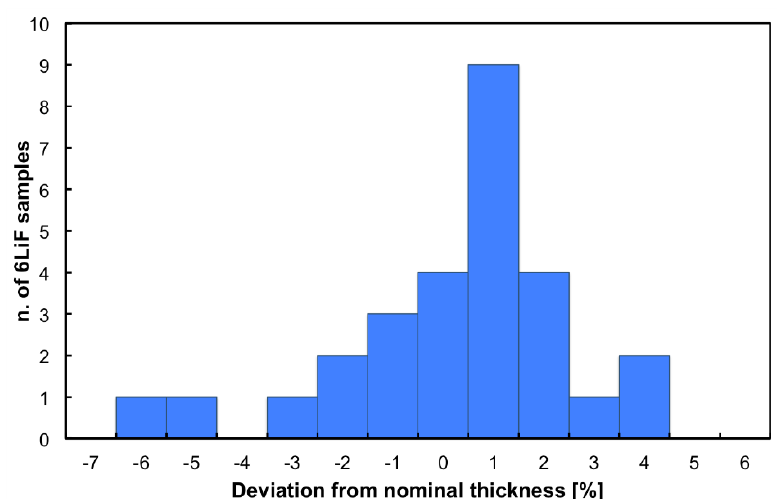
Figure 3. Distribution of the deviation of the effective areal density with respect to the nominal value (in percent) for 28 tested samples.